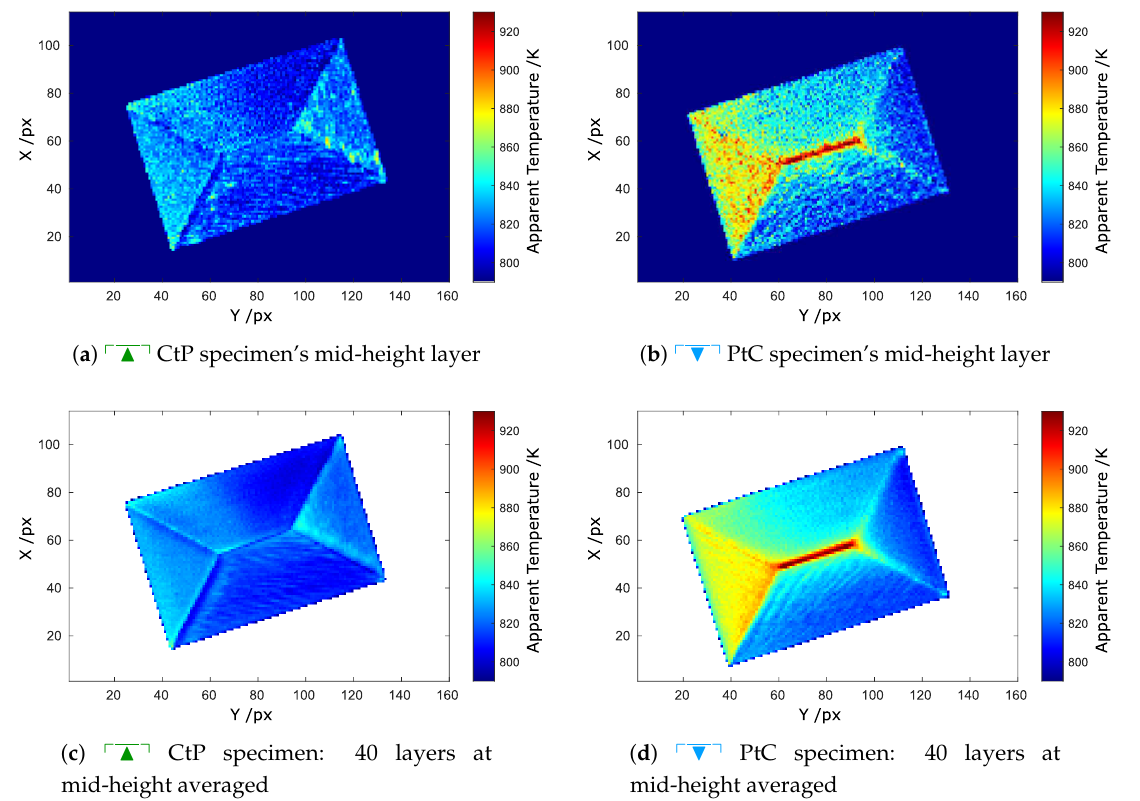
Figure 3. Apparent (uncalibrated) maximum temperature of the two specimens obtained from thermography data acquired during the build process at the sample’s mid build height. Each border fill scan started and ended at the bottom right hand laser turn position of the images. ( a , b ) display the mid-height layer, ( c , d ) display an average of 40 layers at the